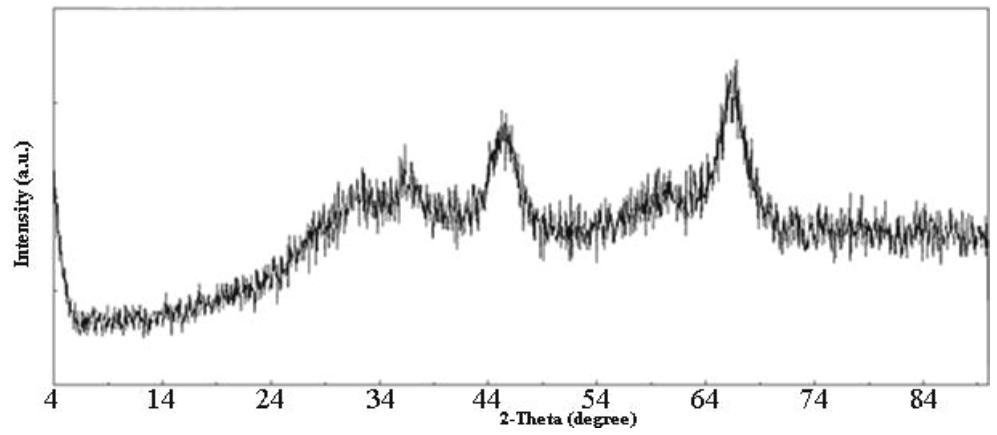
Fig. 3. XRD pattern of C2 catalyst calcined at